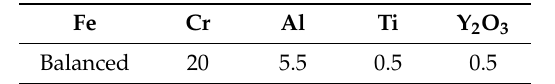
Table 1. PM2000 nominal composition (wt %).